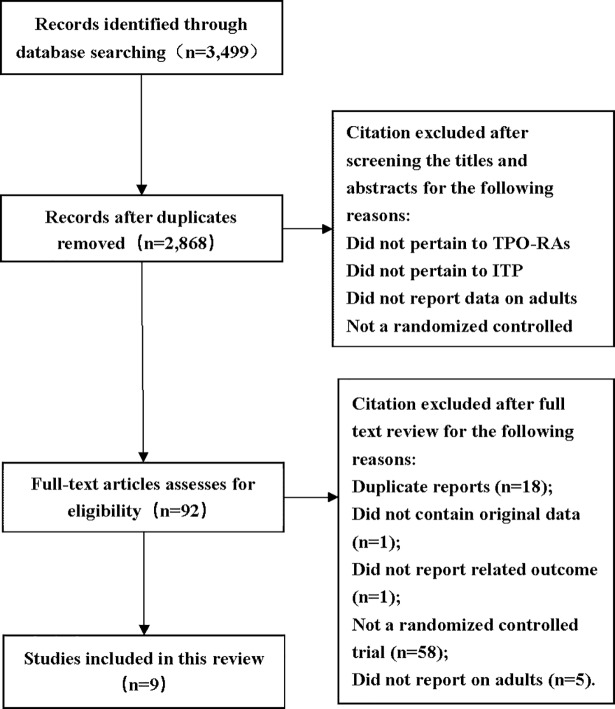
Flow diagram of study selection process for this systematic review.